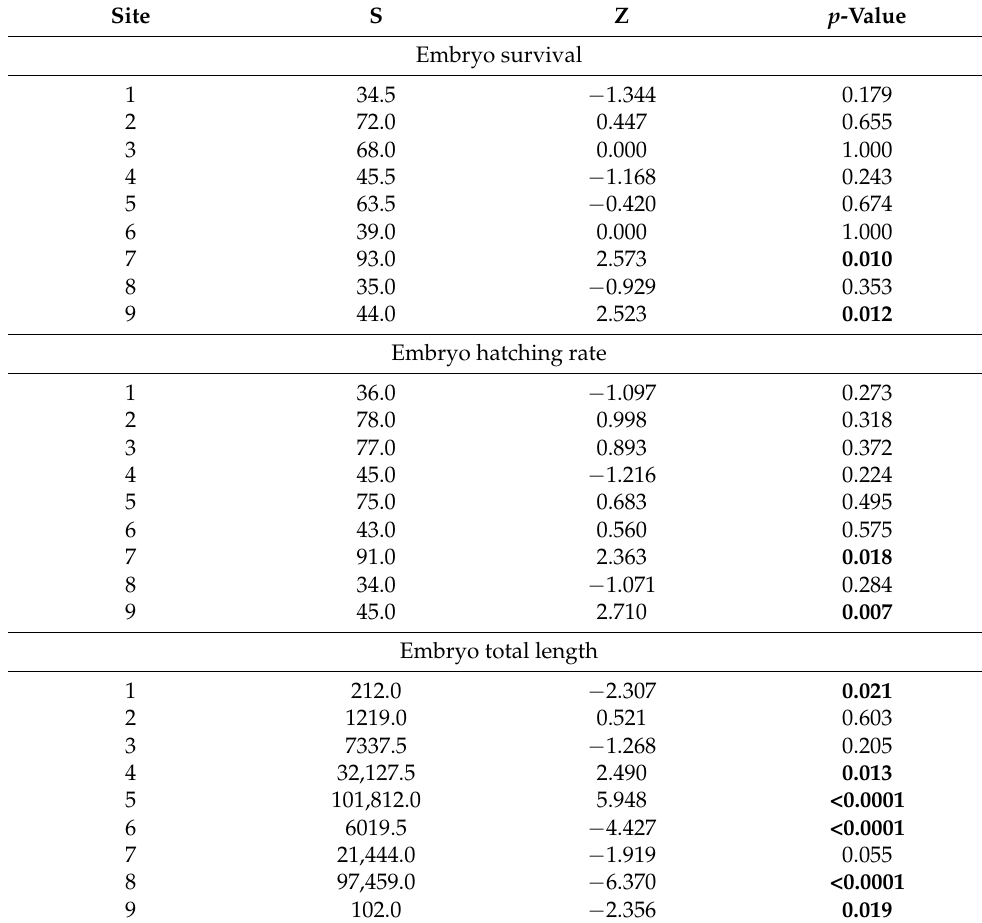
Table 4. Results of Wilcoxon rank-sum tests for within-site differences in embryo survival rate, hatching rate, and total length between areas containing and lacking (control) in-channel structure. Z represents the test statistic and S represents the total rank sum. Bold indicates statistical significance ( p < 0.05). Site S Z p -Value Embryo